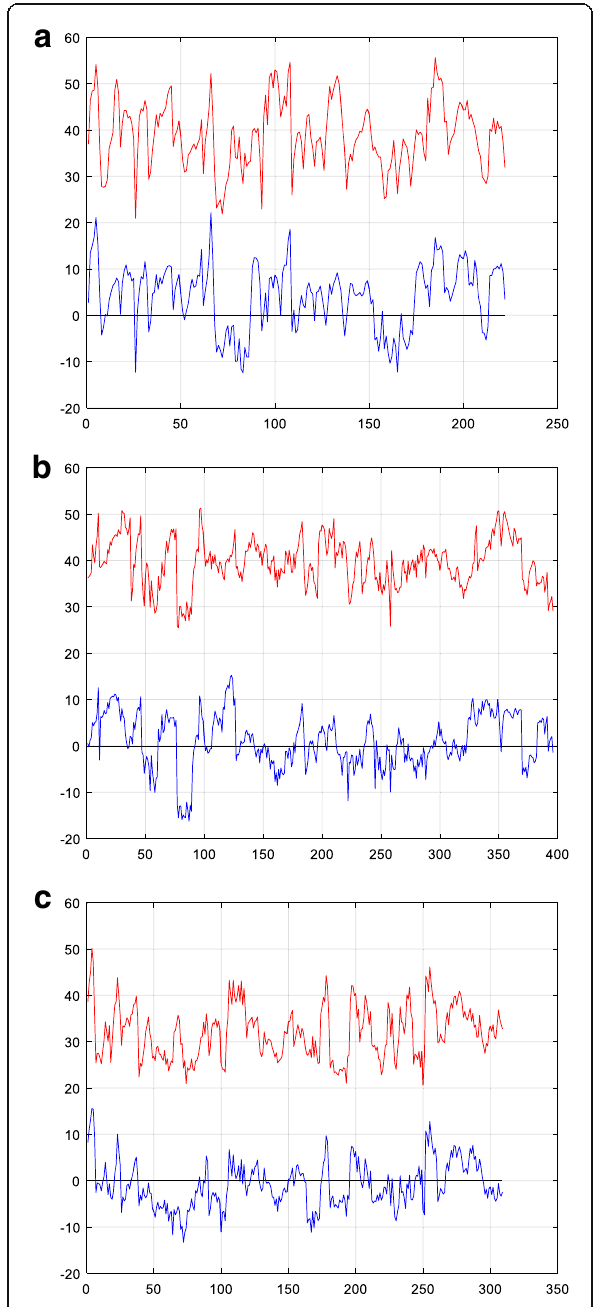
Fig. 17 Y -axis represents the pixel number. Red curve : the error of the A parameter (expressed in pixels) between the values obtained by the CLNF and the ground truth value. Blue curve : the error of the A parameter (expressed in pixels) between the values obtained by the periodical spline method and the ground truth value. ( a – c ) correspond to the result of three